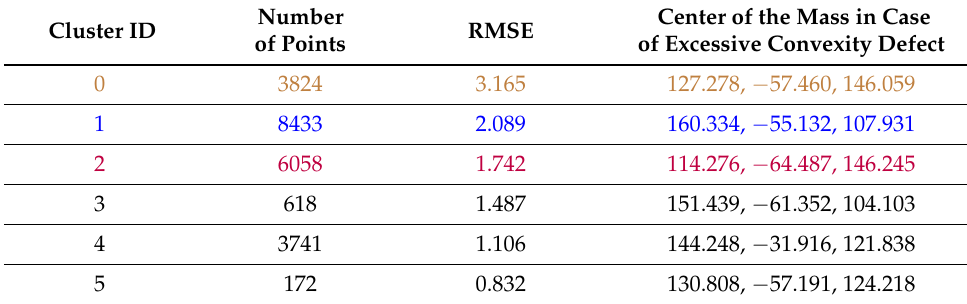
Table 3. The values of the clusters. The text colors are matched with Figure 7. Number Center of the Mass in Cluster ID RMSE of Points